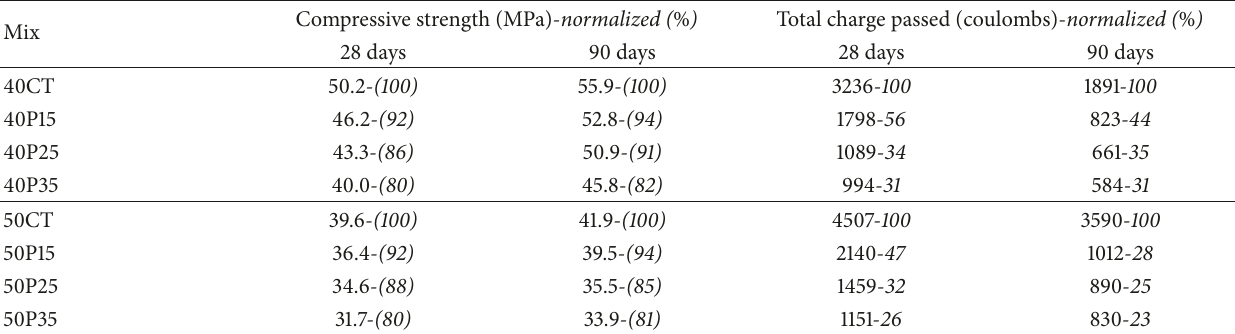
Figure 4: Chloride ion penetration and the replacement of ground POFA in concrete for W/B ratios of 0.40 and 0.50. Table 5: Compressive strengths and chloride ion penetrations of the types of